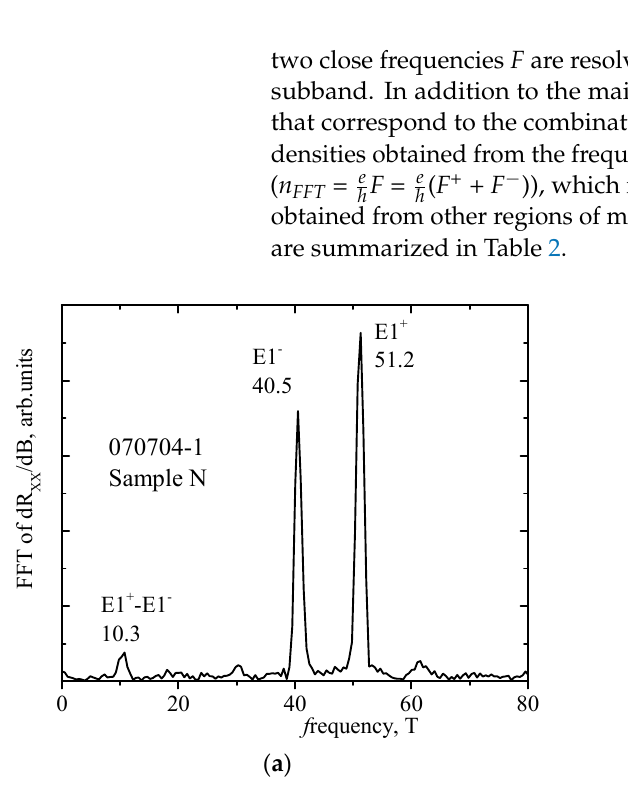
Figure 4. FFT spectra of SdH oscillations of Sample N ( a ) and Sample I ( b ). The Fourier peaks are labeled as E1 + and E1 − for Sample N and H1 + and H1 − for Sample I according to corresponding spin-split subbands. Differential peaks are denoted as well.